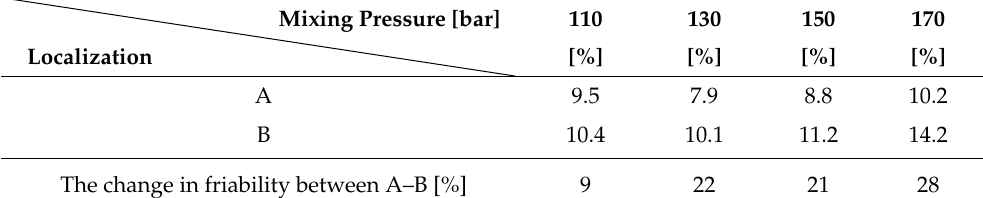
Table 4. Friability